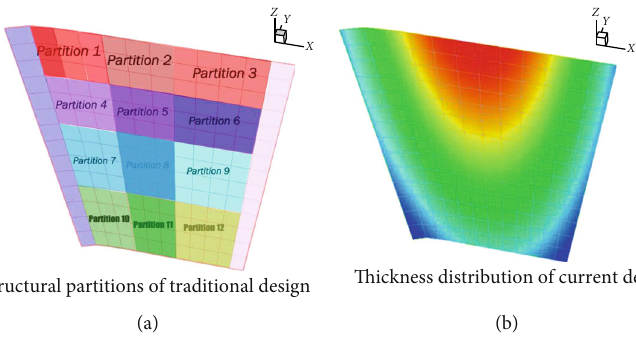
Figure 3: Comparison of design variables of wings.